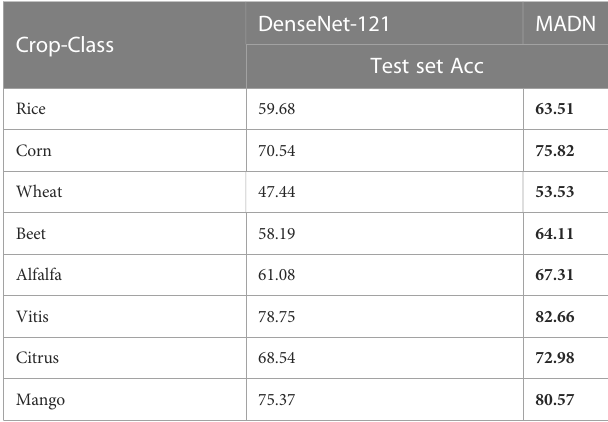
TABLE 6 Experimental results of MADN and DenseNet-121 on eight crops test set.